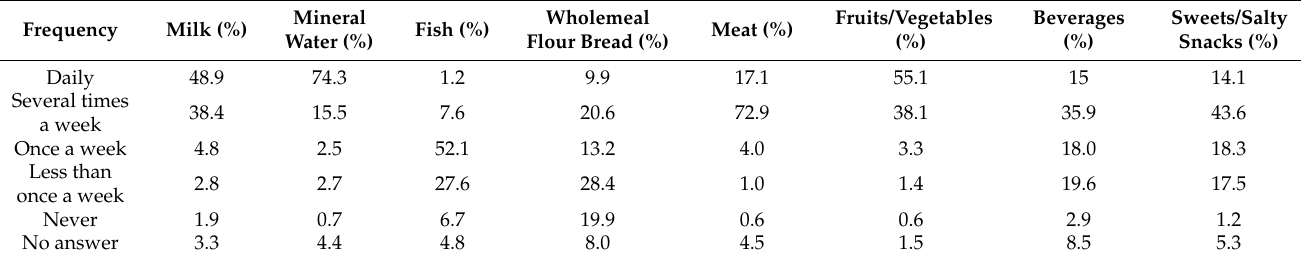
Table 4. The frequency of consumption of milk, water, fish, wholemeal flour bread, meat, fruits/vegetables, beverages and sweet/salty snacks by children.